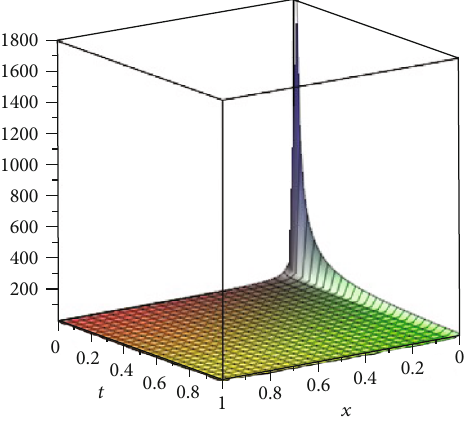
ð x , t Þ of Equation (57). Figure 14: u Figure 13: u 2,3